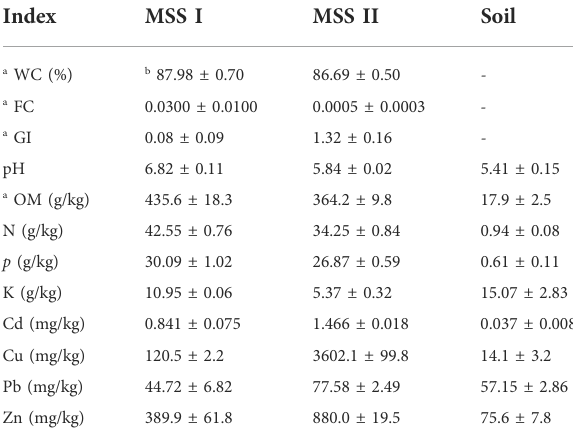
TABLE 1 Municipal sewage sludge (MSS) and soil